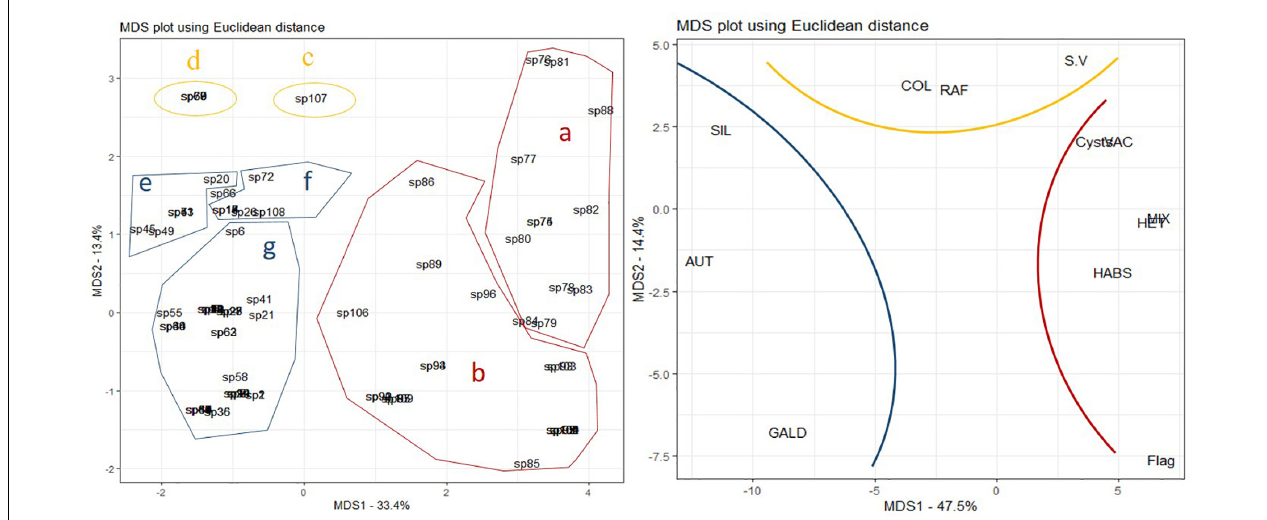
FIGURE 5 | Non-Parametric Multidimensional Scaling (NMDS). Letters denote species groups and colors highlighted traits. GALD, greatest axial linear dimension; S.V, surface to volume ratio; VAC, presence of large vacuoles; SIL, presence of silica structure; COL, coloniality or chain formation; RAF, presence of raphe; HABs, Harmful algal bloom formation capacity; AUT, autotrophy; HET, heterotrophy; MIX, mixotrophy; CYST, resting stages; FLAG, presence of flagella.